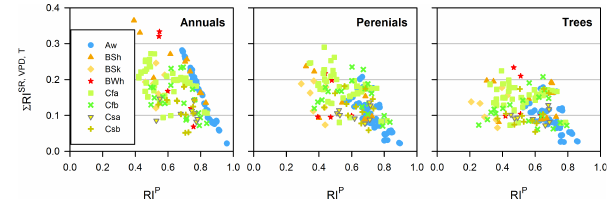
Fig. 5. Scatter plots of relative importance of rainfall (RI p ) and the sum of relative importance of T , VPD and solar radiation (RI SR , VPD ,T ) within considered climate types for three vegetation types and soil with hydraulic conductivity K = 1 . 0md − 1 .